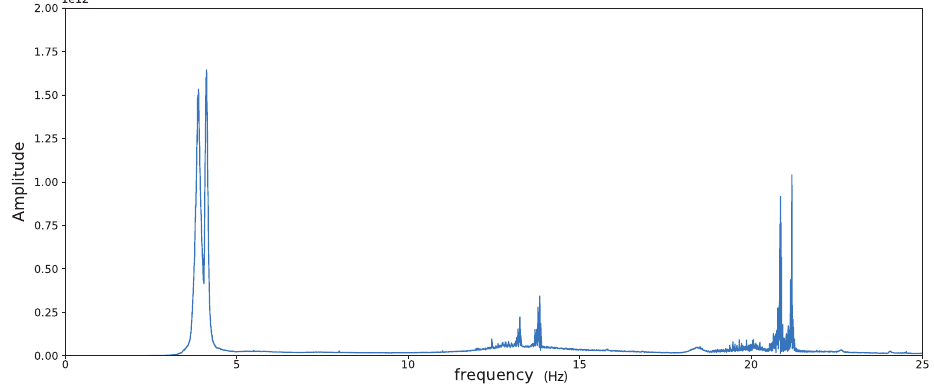
Figure 3. The first singular value of the reference cross-correlation matrix (computed using the first 8 days of acquisition) as a function of frequency (in Hz), σ r natural frequencies of the structure are given in Table